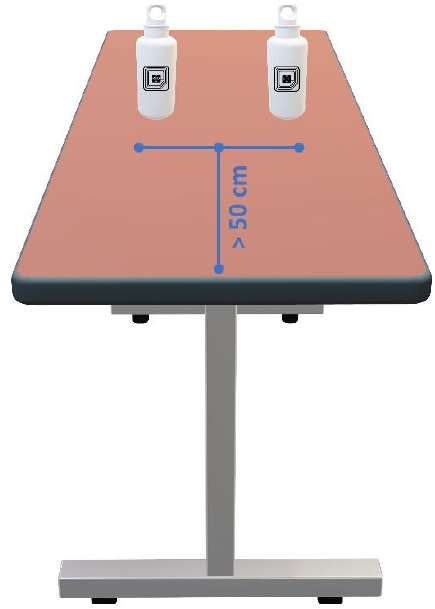
Figure 8. A schematization of the experimental setup which was used for the assessment of the device in the case of handled